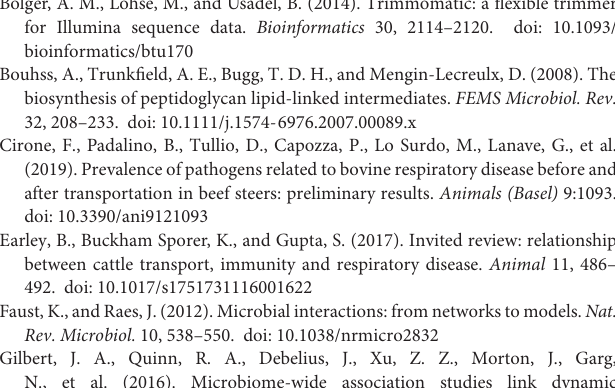
Supplementary Table 7 | The detailed statistics data of relative abundance differences in KOs among groups. Supplementary Table 8 | Statistical table of alpha diversity for each